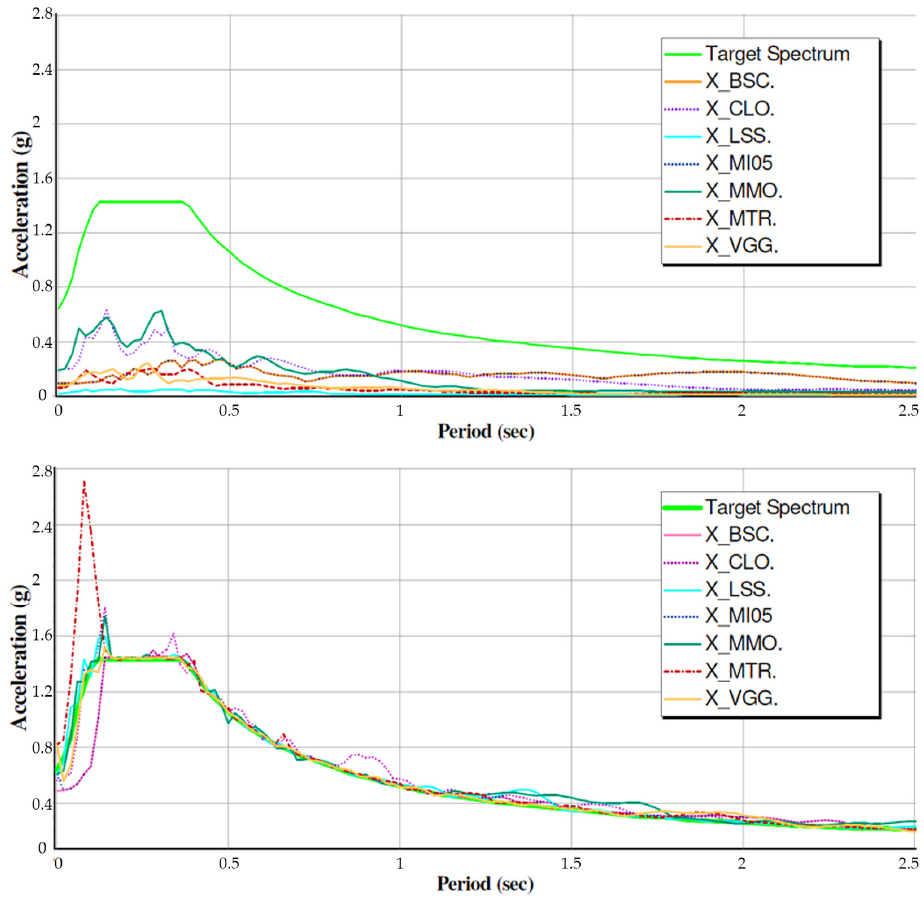
Figure 7. Response spectra of the selected accelerograms in Table 4 in X direction ( upper ) and the respective matching response spectra ( lower ).